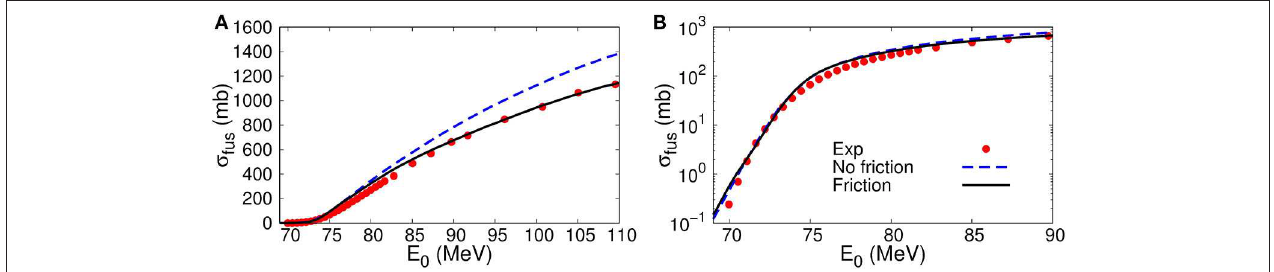
FIGURE 2 | Energy dependence of fusion cross sections for the 16 O + 208 Pb system. The results with and without friction are shown by the solid and the dashed lines, respectively, while the experimental data are shown by the circles. The left panel (A) is in the linear scale, while the right panel (B) is in the logarithmic scale. The experimental data are taken from Morton et al.